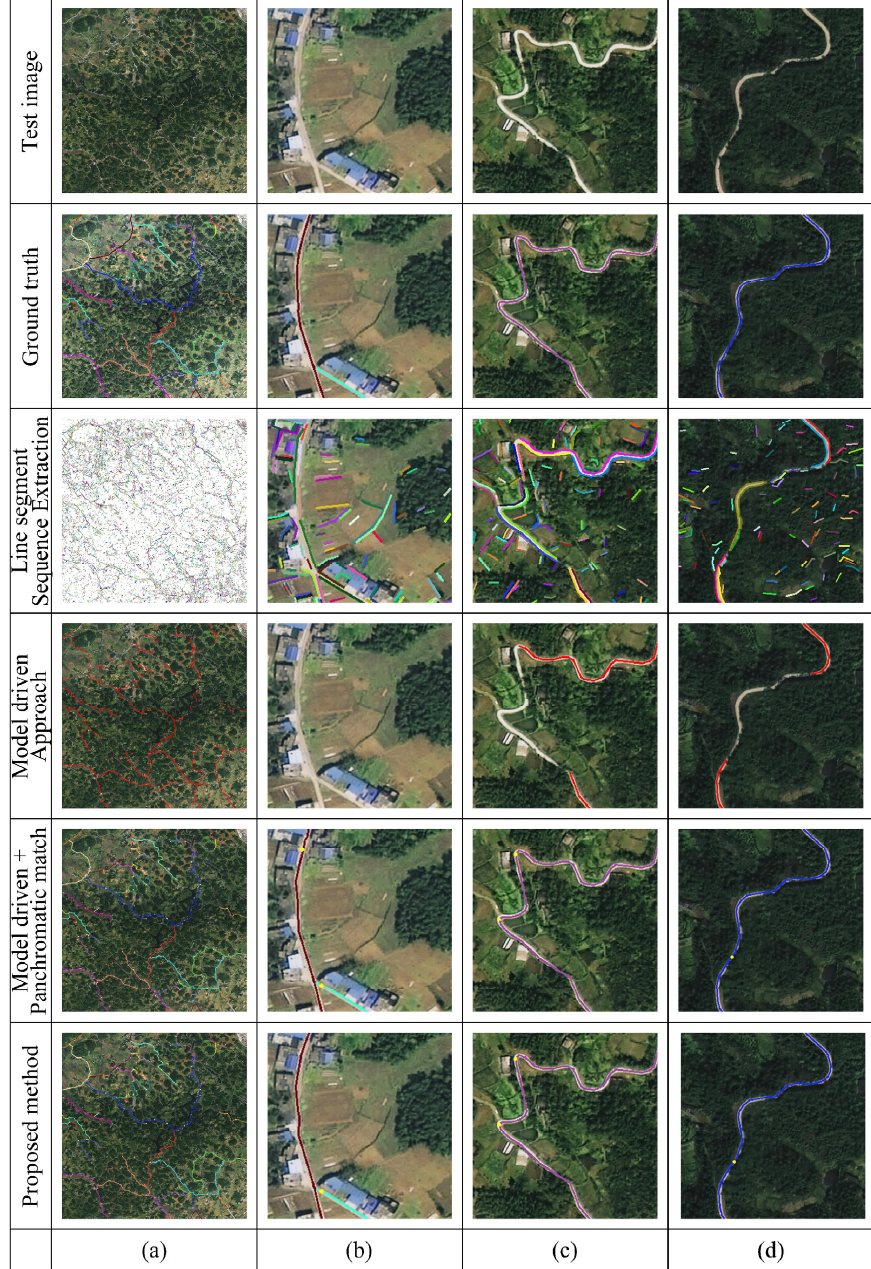
Figure 16. This is a figure. Extraction results of different steps from GF-2 image in a rural area (different colored curves represent different routes). (different colored curves represent different